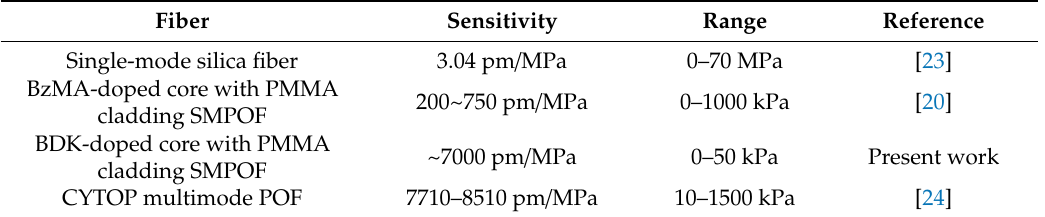
Table 2. The di ff erent sensitivities reported by research